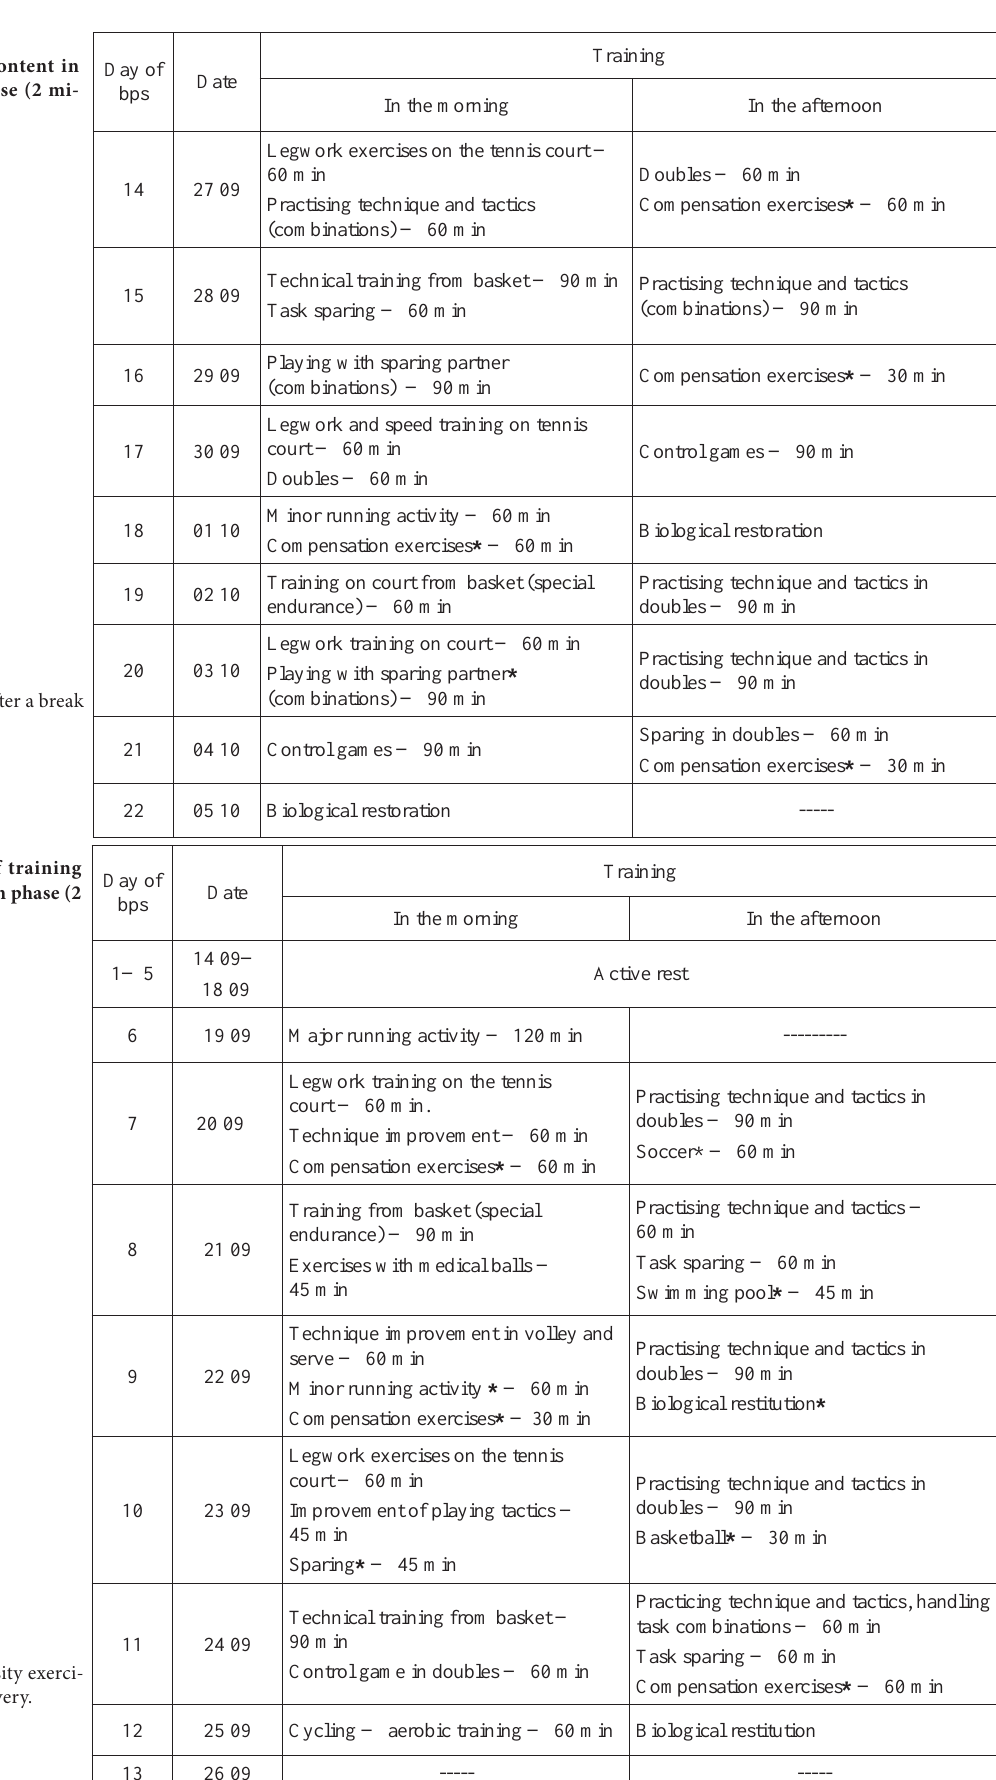
Table 1. Training content in the restoration phase (2 mi- crocycles)